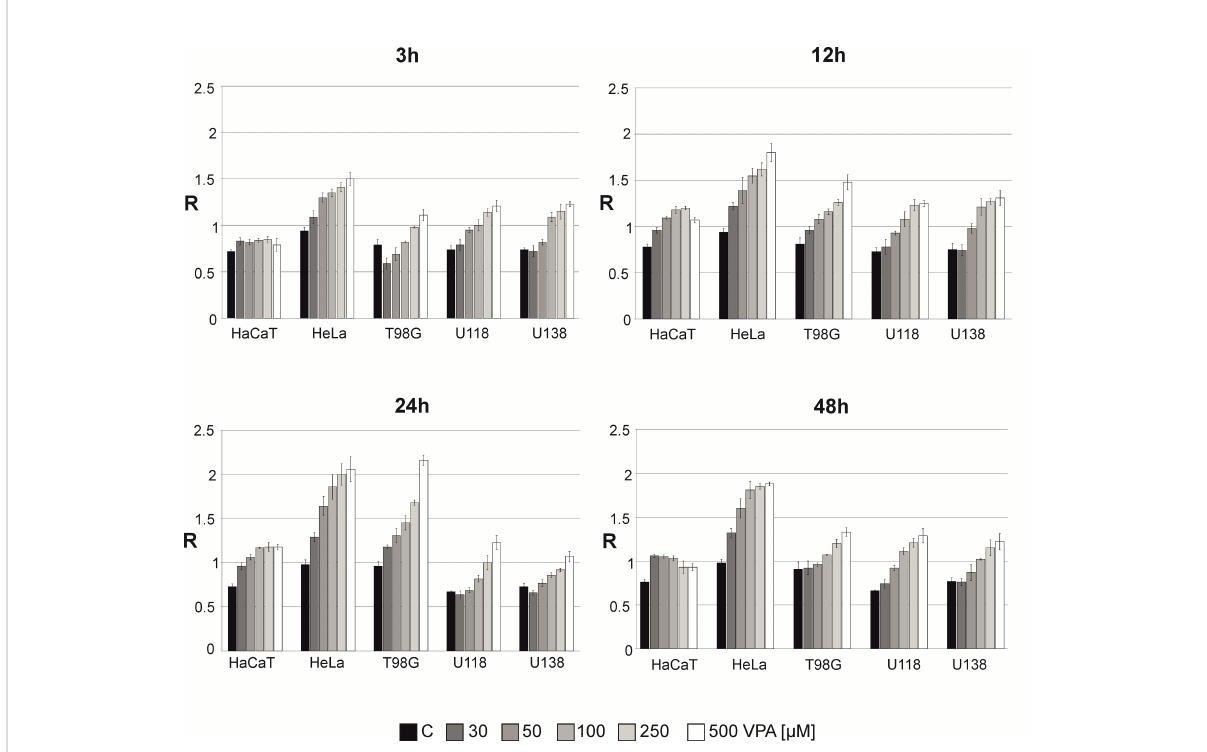
FIGURE 3 The effect of valproic acid (VPA) on DNA (m 5 C) methylation level (R) in different cell lines. The analysis was performed after 3, 12, 24, and 48 h of incubation in a given VPA concentrations (0, 50, 100, 250, 500 m M). For control experiment cells were treated with H 2 O. The R values are means from three